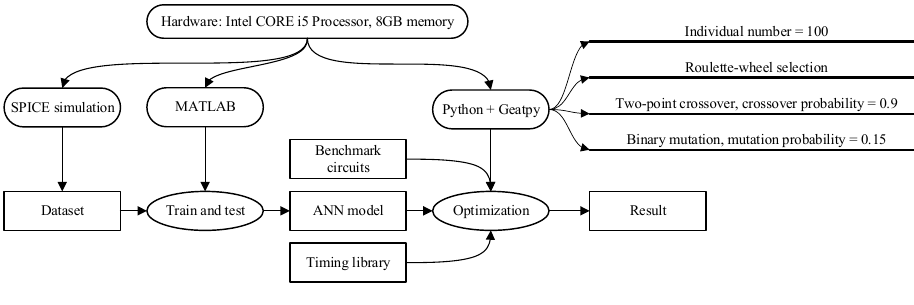
Figure 11. Experimental setup.